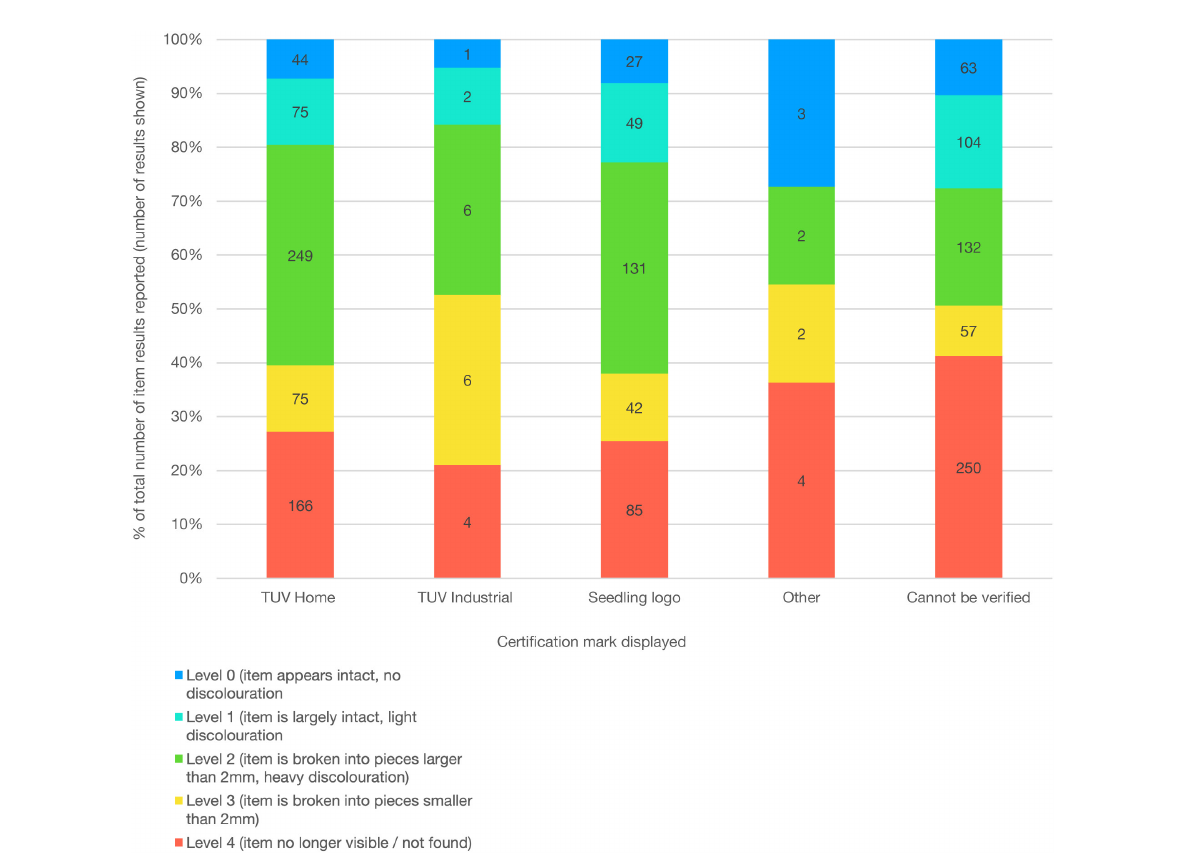
FIGURE13 Chart showing home compost experiment item degradation level according to displayed compost certification. Values calculated from 1,307 item results submitted. Items displaying multiple certification marks